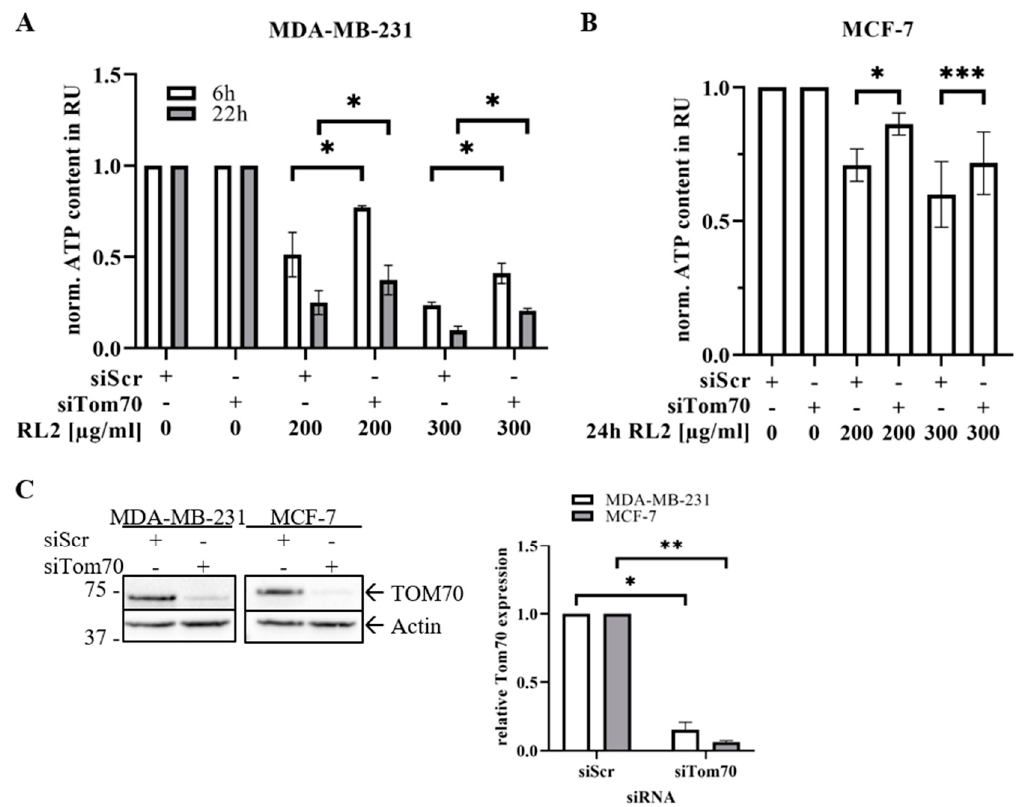
Figure 7. TOM70 knock-down rescues RL2-induced drop of ATP levels in MDA-MB-231 and MCF-7 cells. ( A ) MDA-MB-231 and ( B ) MCF-7 cells were transfected with TOM70 siRNA (#AM16708,